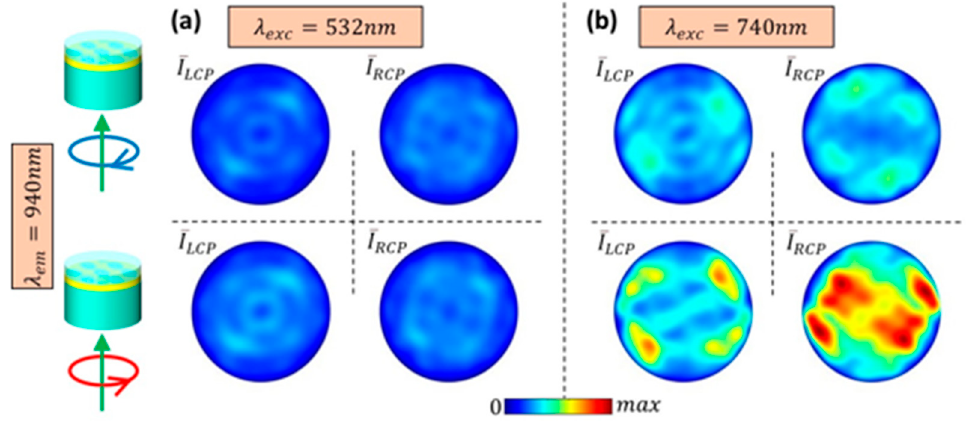
Figure 8. I̅ (cid:2896)(cid:2887)(cid:2900) and I̅ (cid:2902)(cid:2887)(cid:2900) far-field maps of the Au-ENHA emitting at 940 nm, when it is excited with RCP (top) and LCP (bottom), at the wavelengths ( a ) (cid:2019) (cid:3032)(cid:3051)(cid:3030) = 532(cid:1866)(cid:1865) , and ( b ) (cid:2019) (cid:3032)(cid:3051)(cid:3030) = 740(cid:1866)(cid:1865) . RCP (top) and LCP (bottom), at the wavelengths ( a ) λ exc = 532 nm, and ( b ) λ exc = 740 nm.